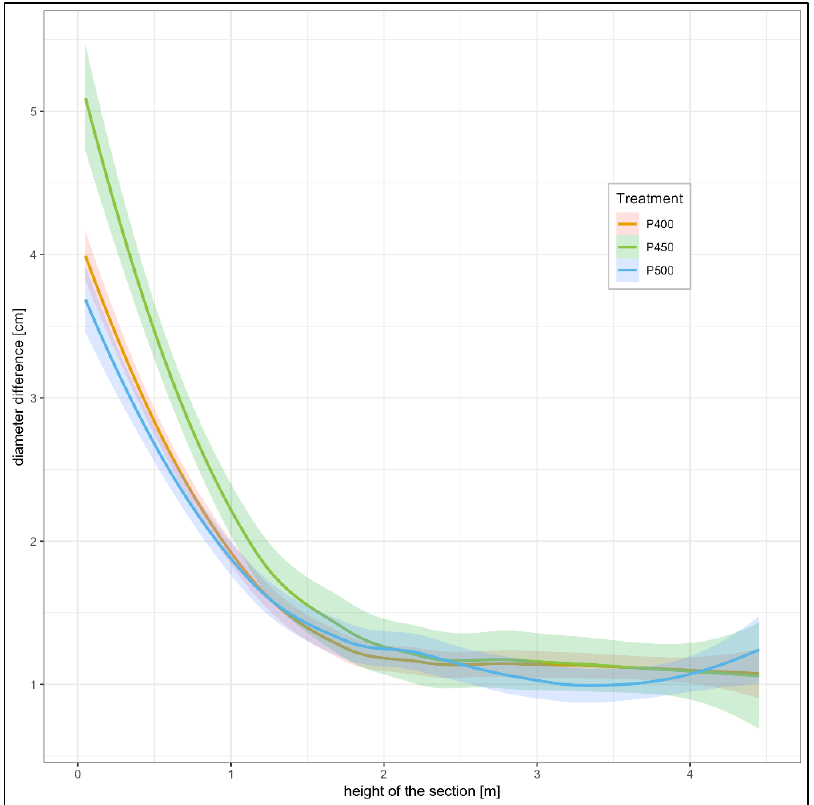
Figure 4. Compression of the stem’s horizontal cross sections: ‘local regression’ and ‘standard error bounds’ of the differences between diameter in the low-competition direction and that in the high-competition direction.